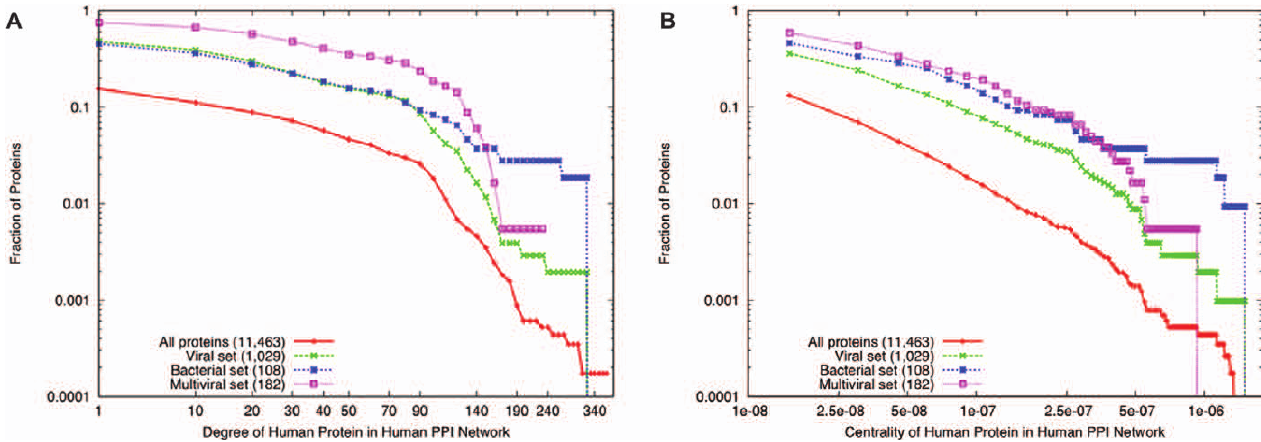
Figure 3. Degree and Centrality Distributions